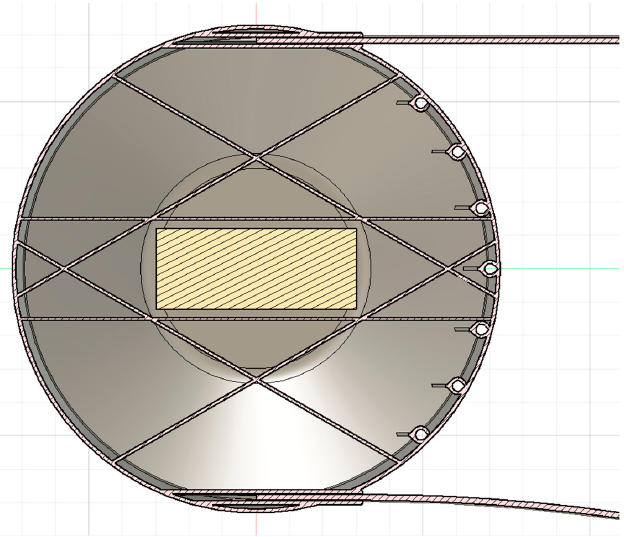
Figure 9. Cross-section through printed “seed” showing location of IMU; the seed OD is 146 mm and the IMU dimensions (hatched) are 60 × 24 × 23 mm (deep).